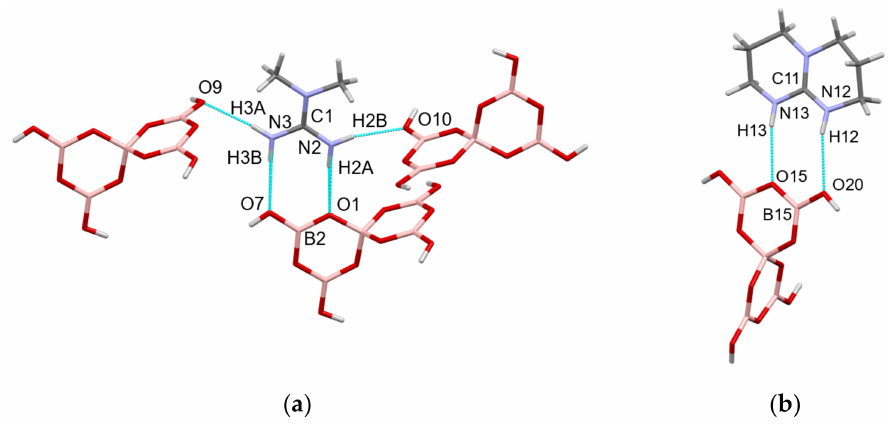
Figure 3. H-bonds originating from the N -substituted guanidinium centres present in compounds ( a ) 2 , and ( b ) 6 , illustrating the “pincer”-like R 22 (8)